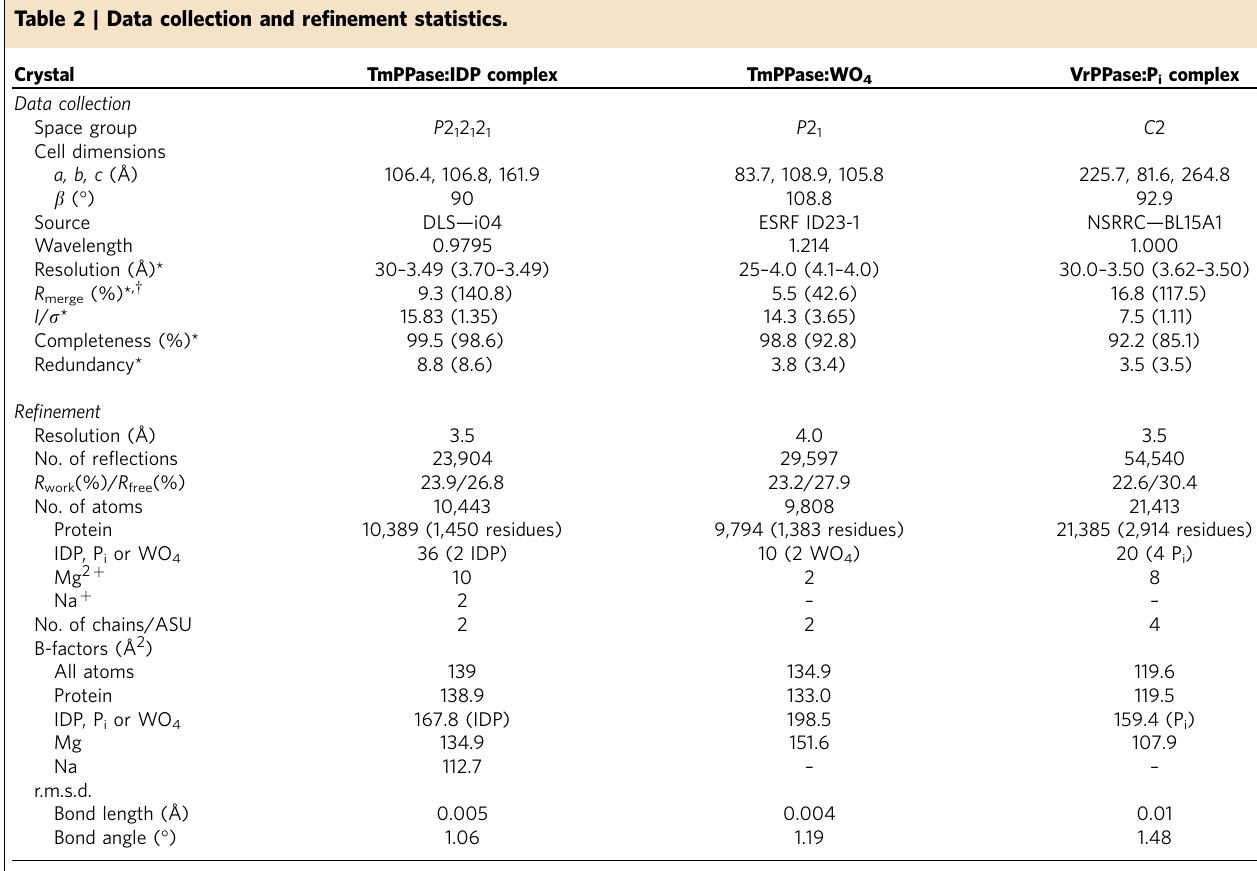
Table 2 | Data collection and refinement